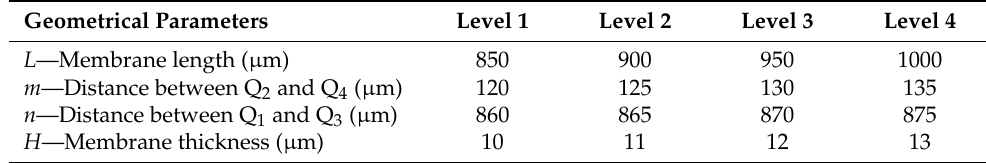
Table 1. Geometrical parameters and levels for the proposed structure.